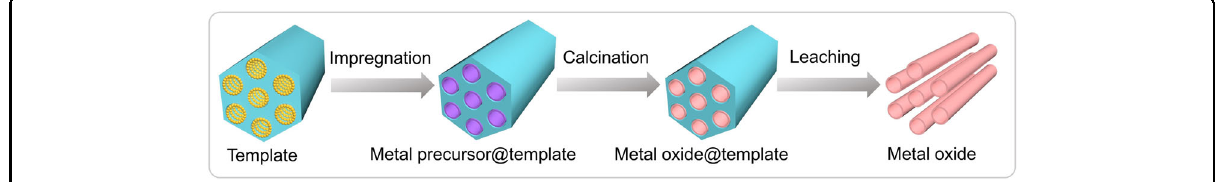
Fig. 7 General synthesis method of mesoporous metal oxides using a hard template. Hard template of mesoporous metal oxide includes three steps: impregnation of metal precursor, calcination to convert the metal into metal oxide, and leaching to obtain the mesoporous metal